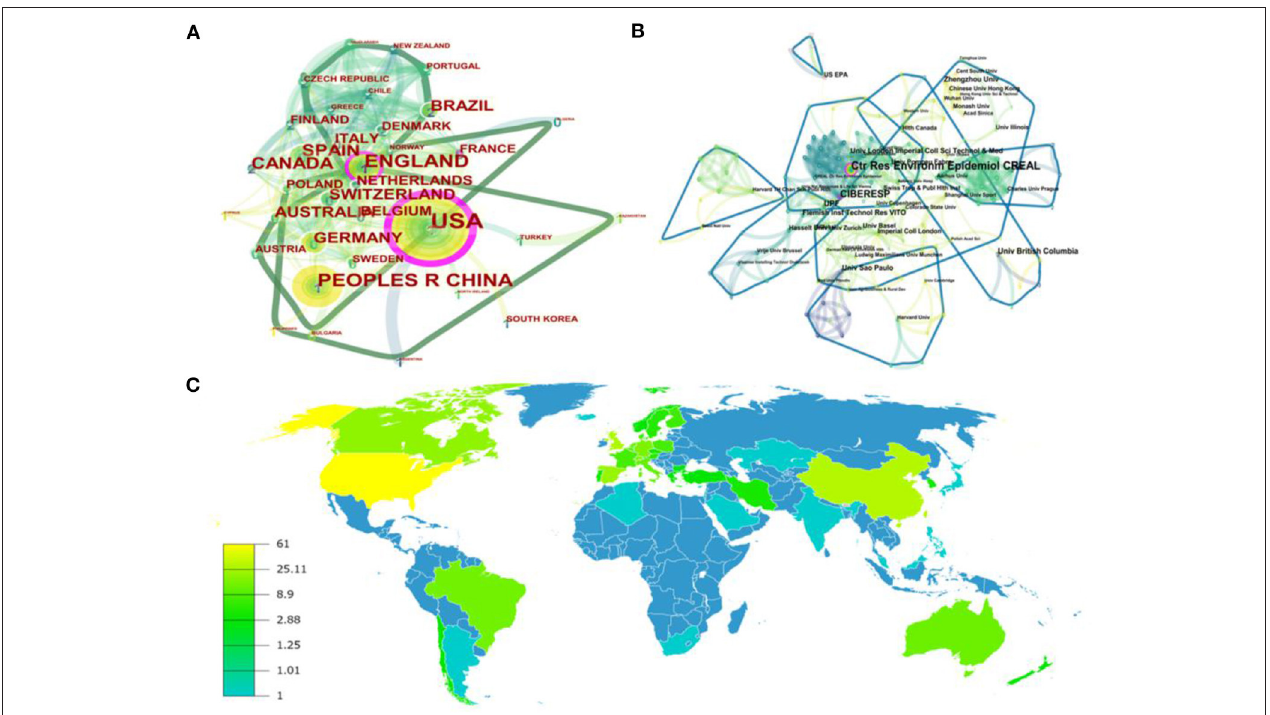
FIGURE 3 | The map of countries (A) , institutions (B) , and world distribution (C) of publications in the AP-PE